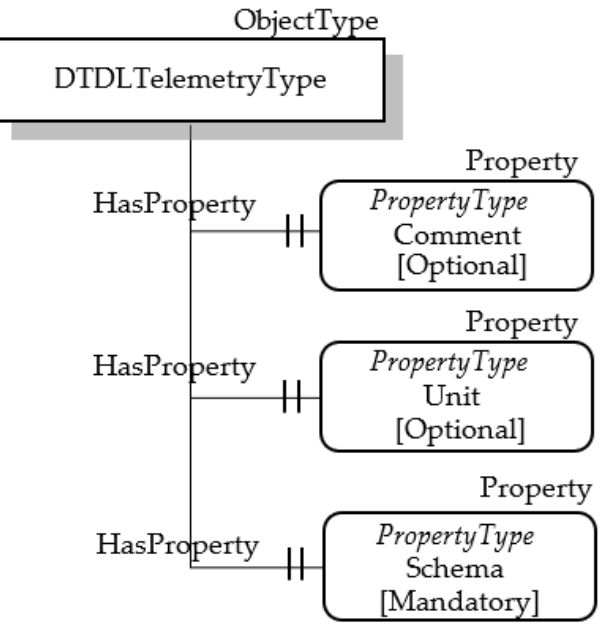
Figure 5. OPC UA DTDL TelemetryType.